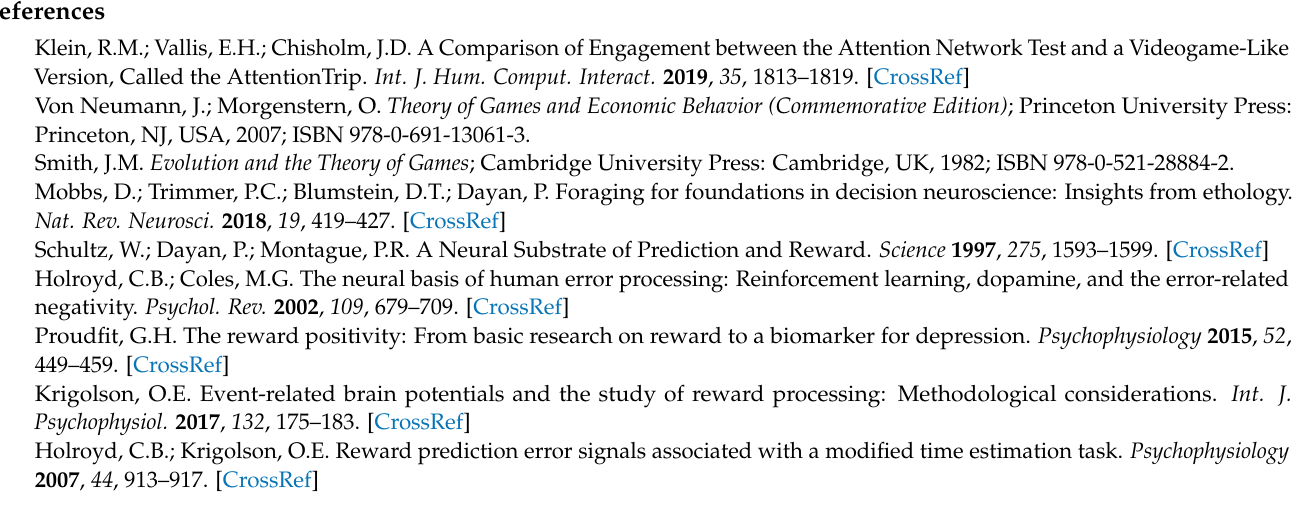
Figure S2: Opponent ability survey for male participants/opponents, Figure S3: Feedback-locked waveforms for (a) expected feedback, (b) somewhat unexpected feedback, (c) unexpected feedback, and associated scalp topographies